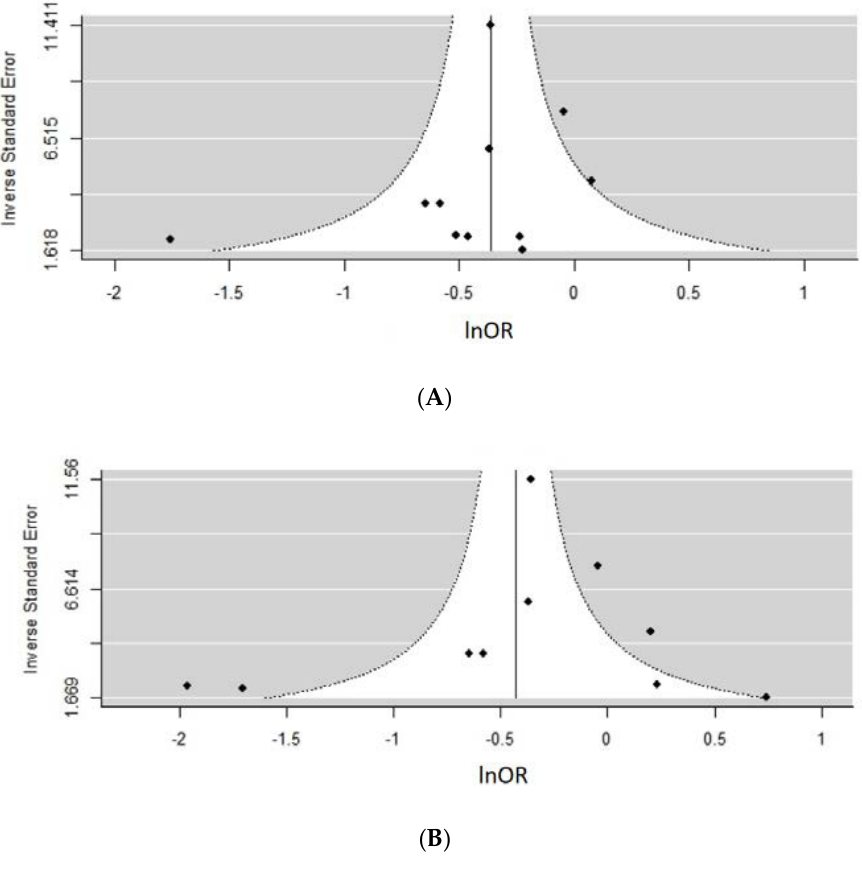
Figure 7. Assessing the risk of publication bias using funnel plots for different metaanalyses. ( A ) Any type pre-pregnancy physical activity (PA) versus none ( n studies = 10, z = −1.52, p = 0.13). ( B ) Pre - pregnancy leisure time PA (LTPA), comparing high versus none regardless of units reported ( n studies = 10, z = −0.65, p = 0.52) Due to insufficient number of studies reporting on early pregnancy period, a funnel plot could not have been performed for some meta-analyses.